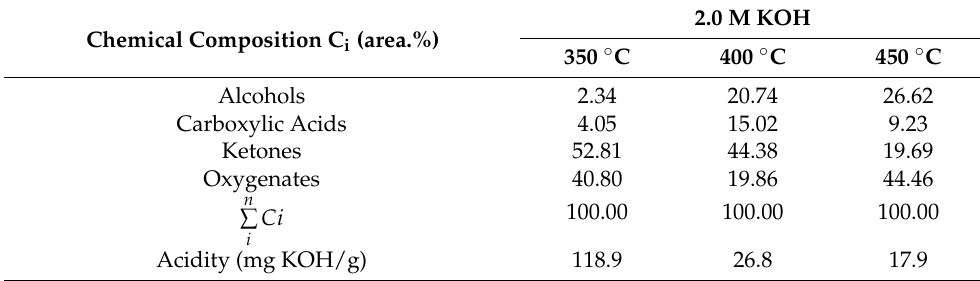
Table 4. Chemical composition and acidity (alcohols, carboxylic acids, ketones, phenols, and other oxygenates) of aqueous phase obtained by pyrolysis of Aça í seeds, activated with 2.0 M KOH solution, at 350, 400, and 450 ◦ C, 1.0 atmosphere, in laboratory scale, identified by GC-MS. Chemical Composition C i